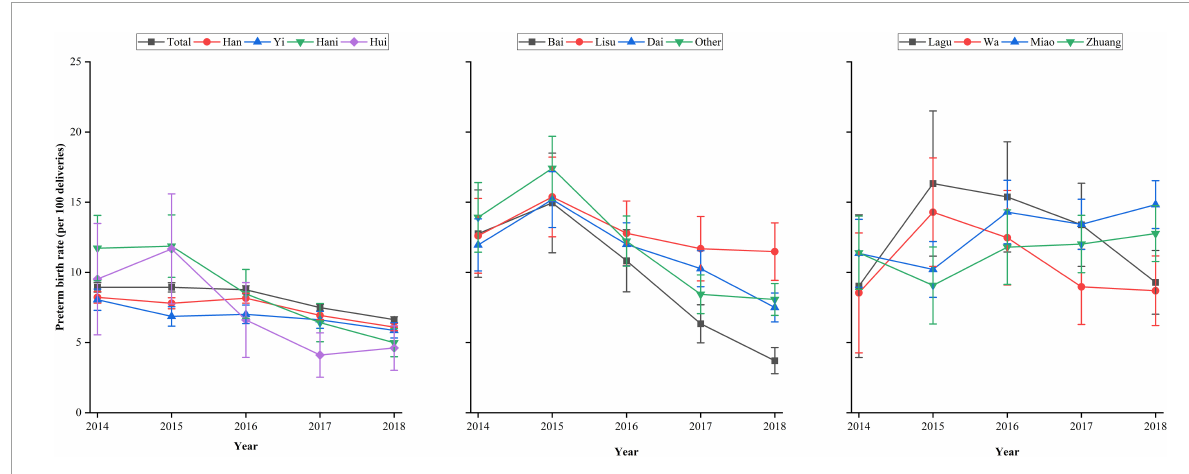
FIGURE3 Preterm birth rates across ethnicities in rural Yunnan, Southwest China, from 2014 to 2018.